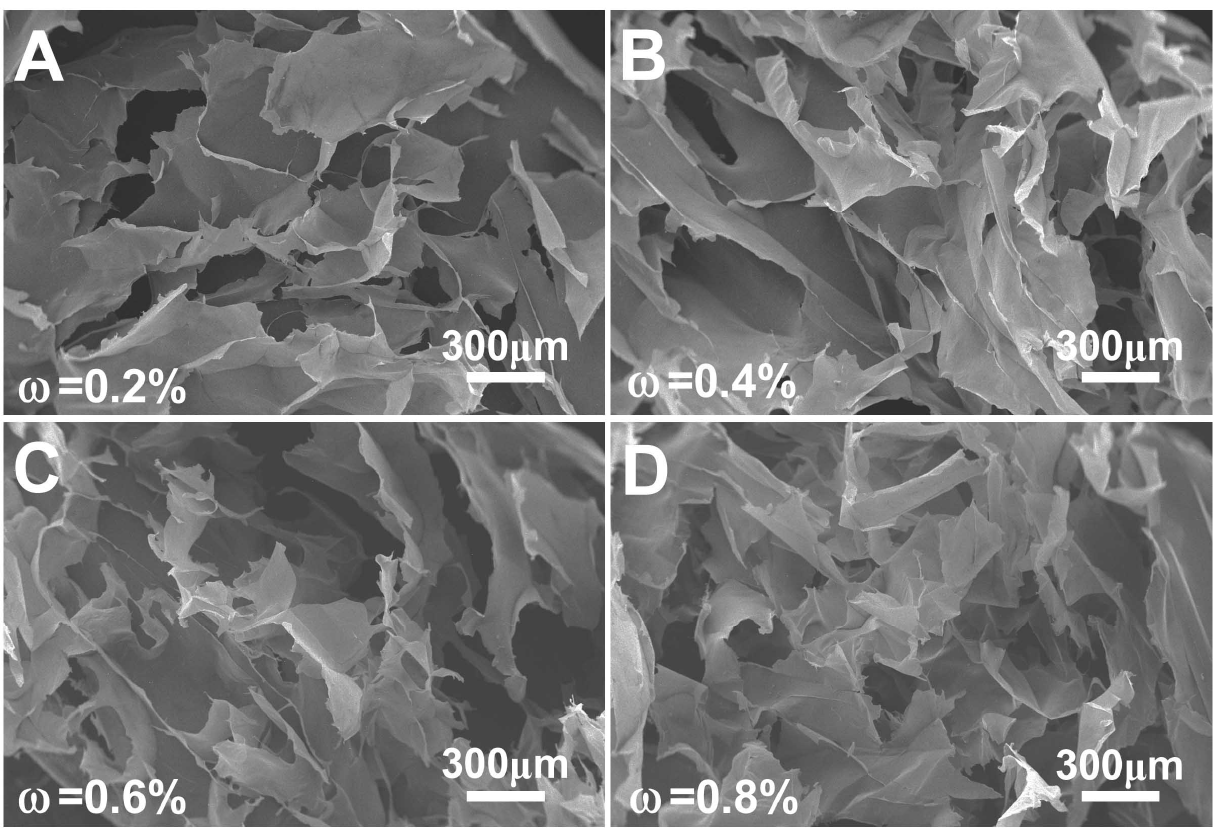
Figure 5. Internal structure of the prepared nano chitin gels with concentrations of 0.2% ( A ), 0.4% ( B ), 0.6% ( C ), and 0.8% ( D ).